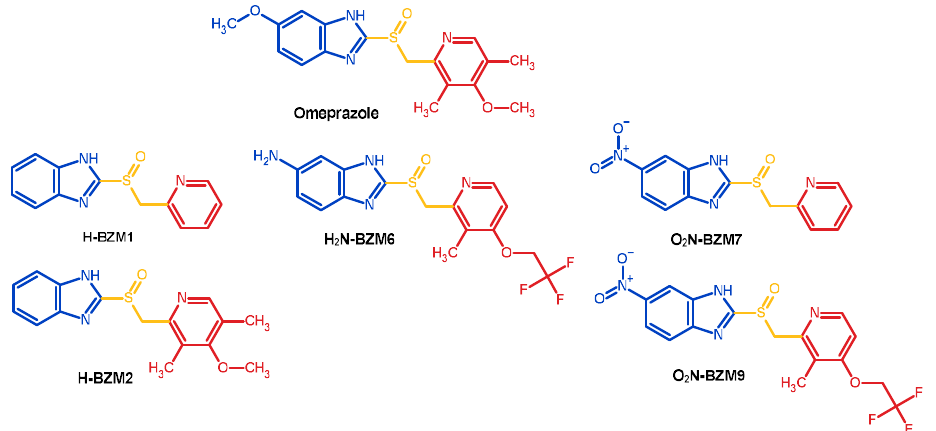
Figure 1. Chemical structure of pyridyl methylsulfinyl benzimidazole compounds analogous to omeprazole; the benzimidazole and pyridine core are shown in blue and red color.